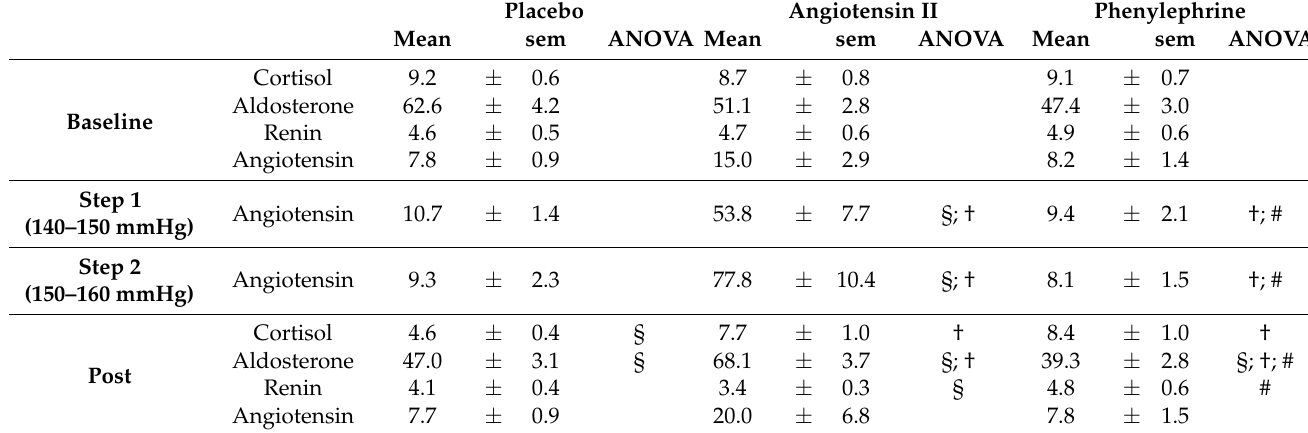
Table 3. Laboratory data at different conditions and periods. Comparison of different periods within condition (ANOVA) § p < 0.05. Comparison of corresponding periods between conditions (ANOVA) † p < 0.05 for Ang II or PE vs. placebo, # p < 0.05 for Ang II vs.